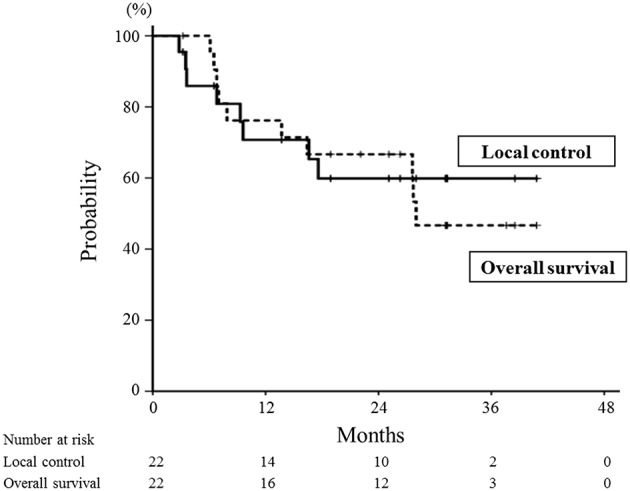
Local control and overall survival curves for all patients treated with re-irradiation by means of carbon-ion radiotherapy. The 1- and 2-year local control rates were 71 and 60%, respectively (solid line). The 1- and 2-year overall survival rates were 76 and 67%, respectively (dotted line).